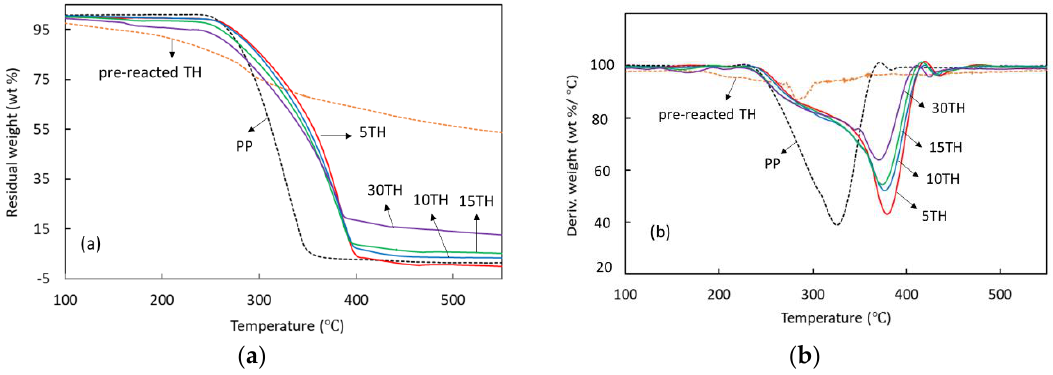
Figure 5. Thermal behaviors of PP and PP/TH composite: ( a ) TGA curves; ( b ) DTG curves.